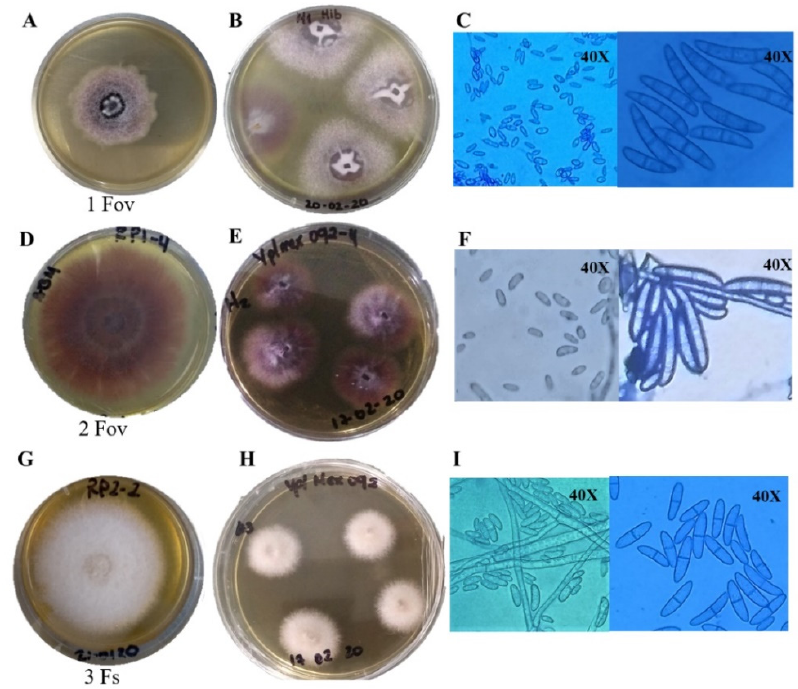
Figure 2. Identified colonies, re-isolation of Fusarium spp. inoculated to evaluate the development of symptoms in vanilla accessions. ( A , D , G ) Colonies on the obverse of monosporic origin of the two isolates F. oxysporum f. sp. vanillae (1Fov and 2Fov) and the F. solani isolate (3Fs); ( B , E , H ). Obverse colonies re-isolated from symptomatic tissue of inoculated plants; ( C , F , I ) microconidia (left) and macroconidia (right) characteristics of the genus Fusarium obtained from each re-isolation.